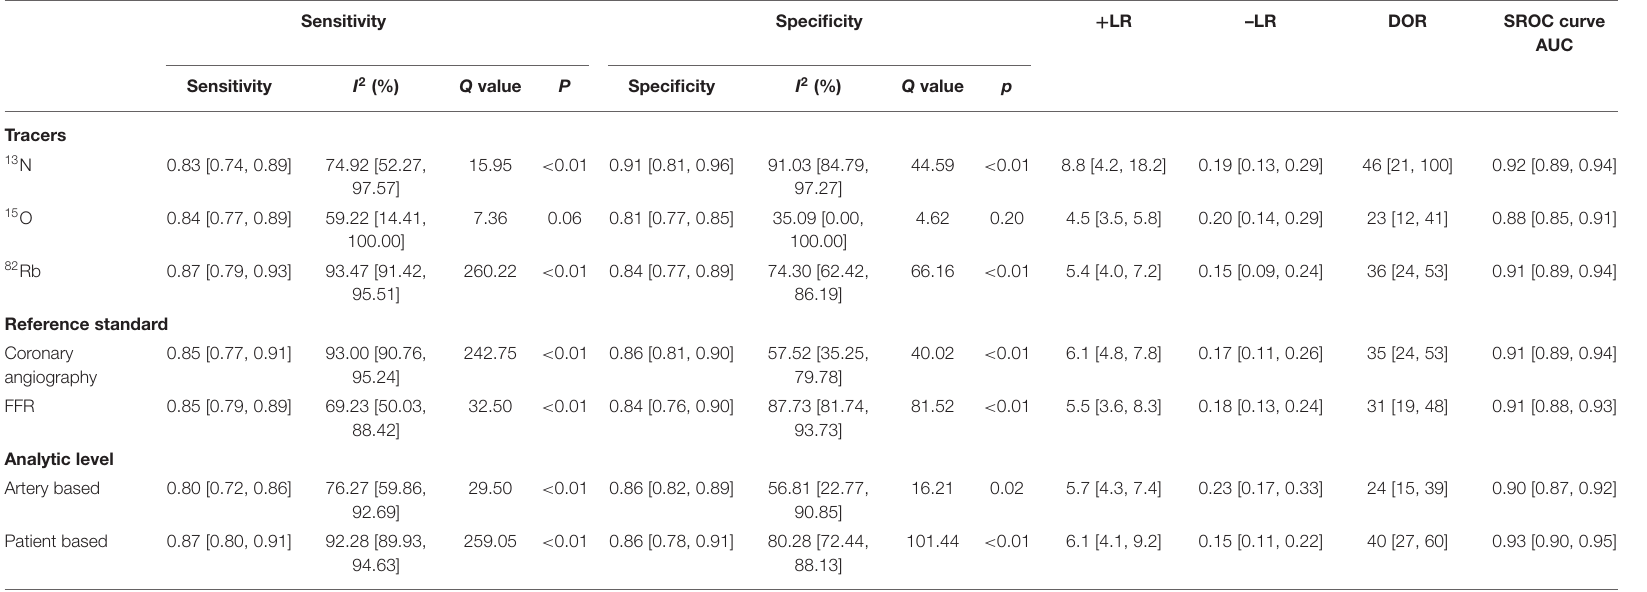
TABLE 4 | Subgroup analysis of PET